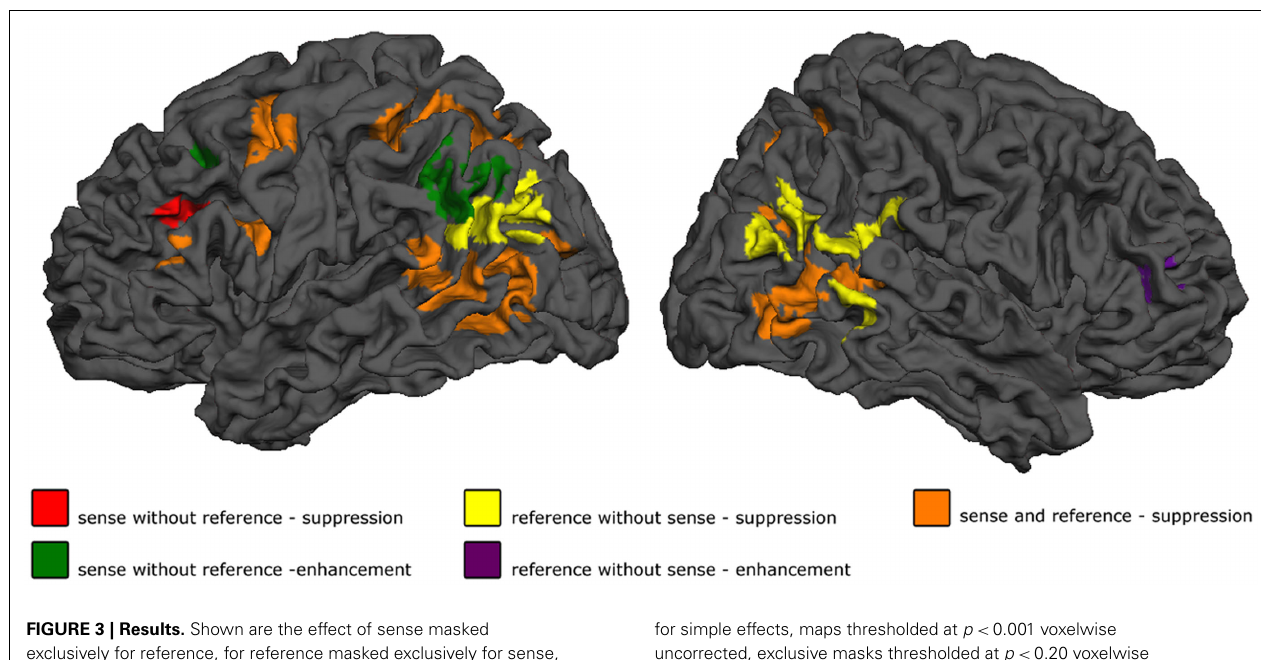
FIGURE 3 | Results. Shown are the effect of sense masked exclusively for reference, for reference masked exclusively for sense, and the conjunction of the two. p < 0.05 cluster-level FWE corrected